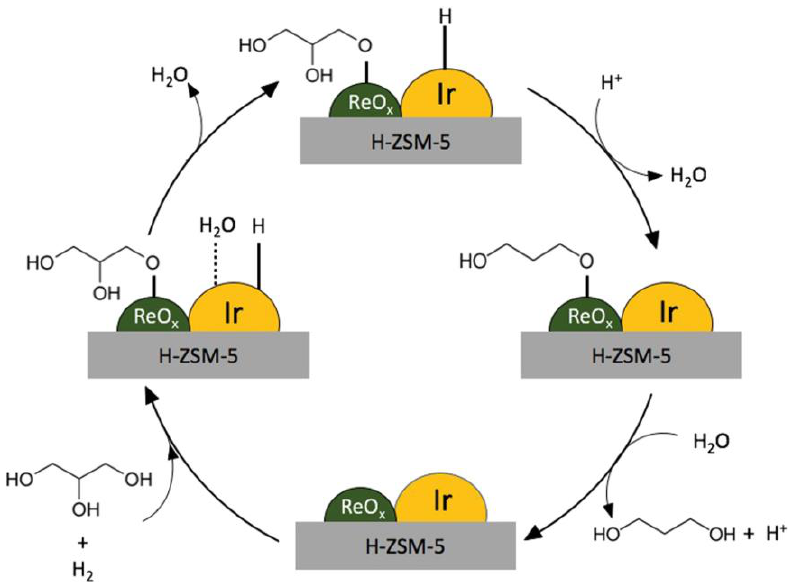
Figure 12. The mechanism for the formation of 1,3-PG in the presence of Ir-ReO x /H-ZSM-5. Repro- duced from [83] with permission from Elsevier. duced from [83] with permission from